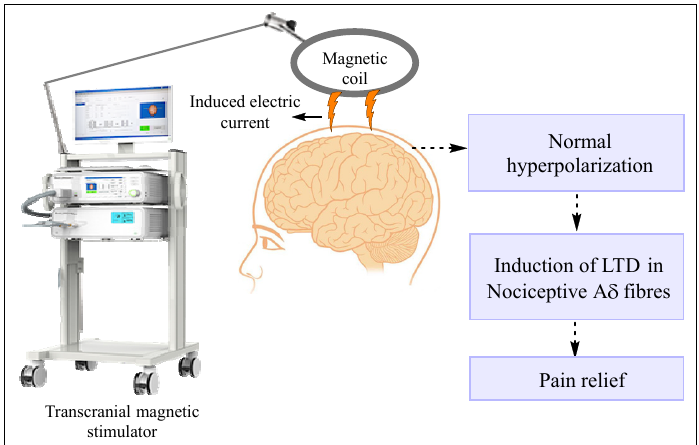
Figure 5. Transcranial magnetic stimulation in the modulation of neuropathic pain. The capacitor is charged at <3 kV, and the circuit is closed via a switch that controls the current flow. An insulated coil placed over the scalp delivers brief magnetic pulses and induces an electric field in the brain to stimulate the nerve cells. Low-frequency (0.3 Hz) repetitive transcranial magnetic stimulation initiates the de novo long-term depression (LTD) of pre-potentiated synapses of nociceptive fibers present in the cortex.